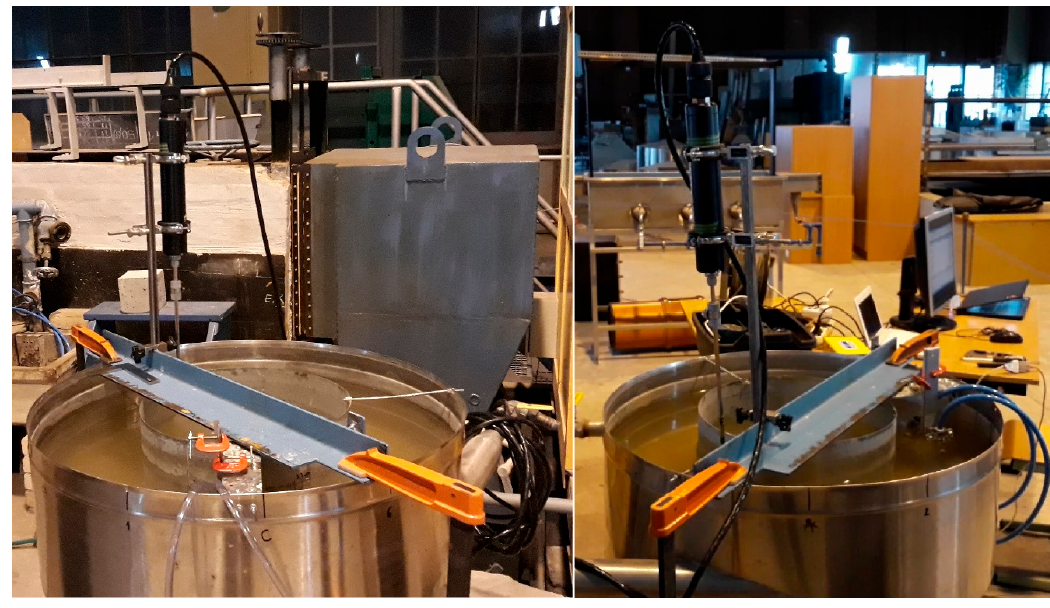
Figure 4. Measuring stand.